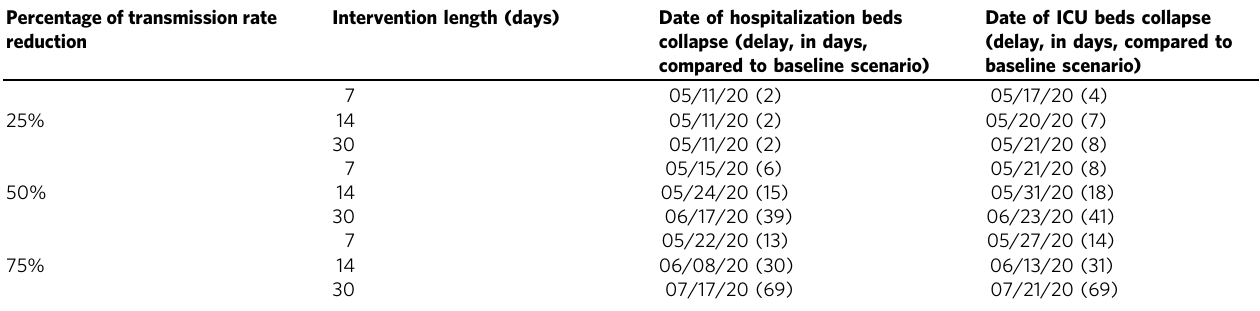
Table 1 Scenarios of an immediate intervention in May 2, 2020, with variations of the transmission rate and intervention length. Percentage of transmission rate